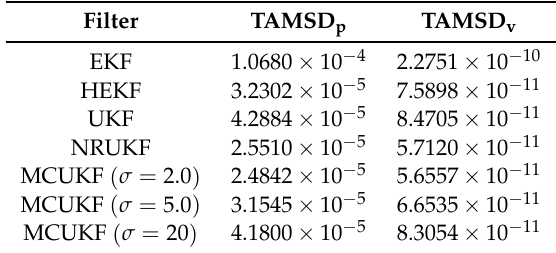
Figure 7. MSD v with different filters in non-Gaussian noises. Table 5. TAMSD p and TAMSD v in non-Gaussian noises.